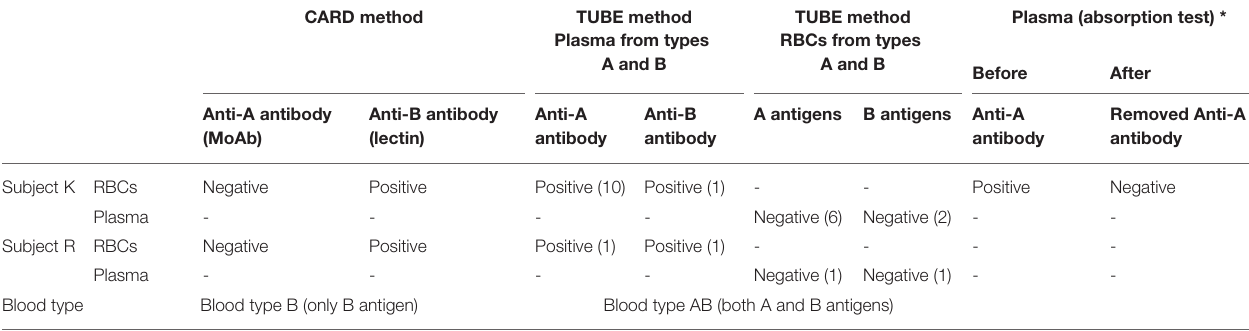
TABLE 1 | Serological investigation of subjects K and R with blood type B as determined by the CARD method.